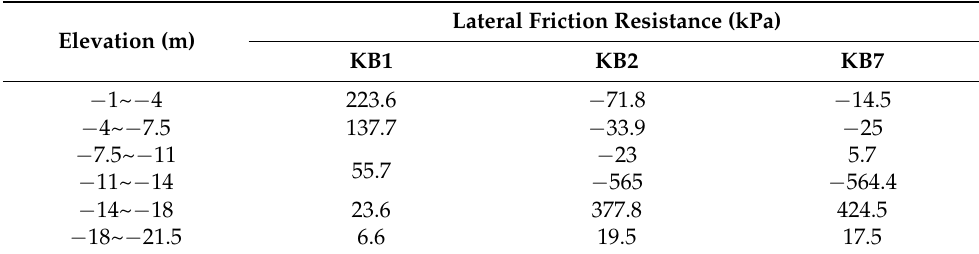
Table 3. Lateral friction resistance of piles under the load of 5520